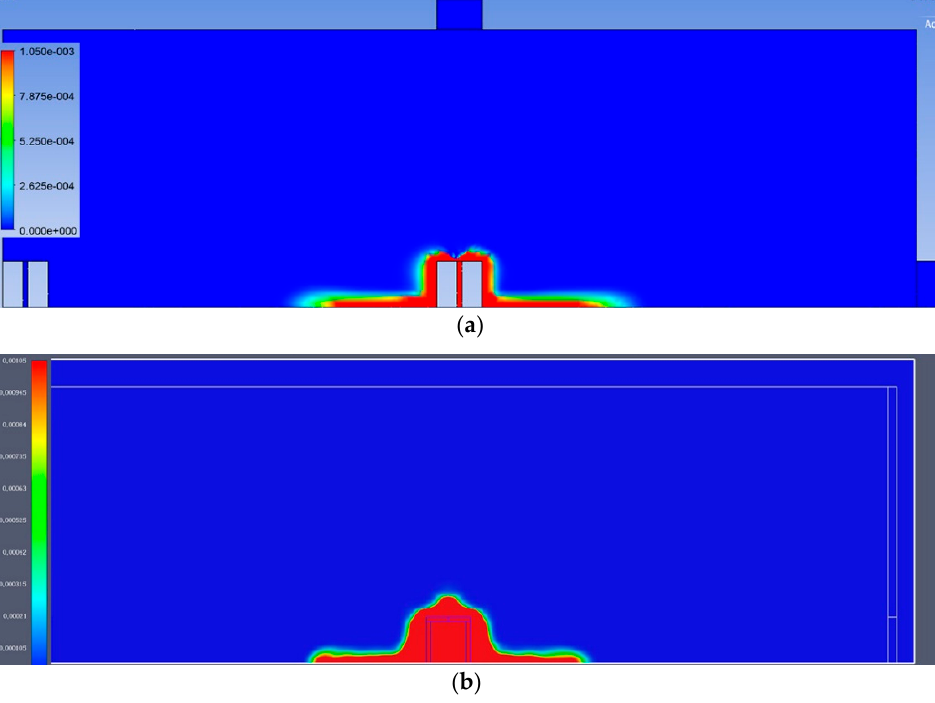
Figure 9. Comparison of propane dispersion for 5% concentration of LEL for time 50 s: ( a ) propane release calculated with Ansys software; ( b ) propane release calculated with FDS software.